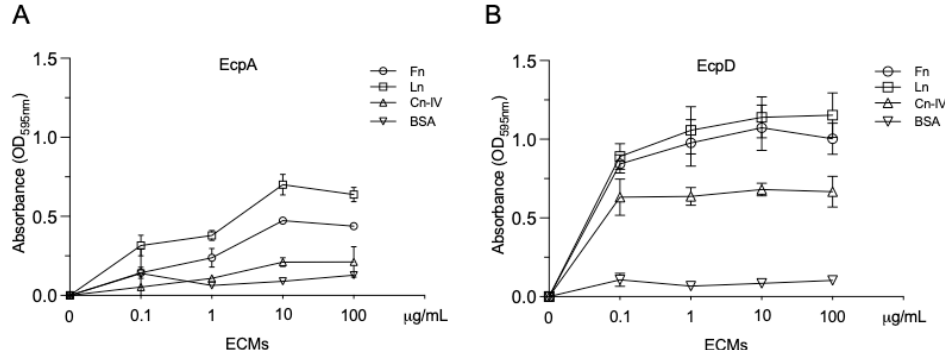
Figure 6. Dose-dependent binding of recombinant His-tagged EcpA and EcpD proteins to immobilized ECM glycoproteins. ( A , B ) Ten-fold dilutions of biotinylated Ecp proteins were added to immobilized ECM glycoproteins to determine dose-dependent binding. After washing, a streptavidin– peroxidase conjugate (1:500) was added to detect the bound biotinylated protein. BSA was used as a negative control. Data shown are the mean of three experiments performed in triplicate on different days (Mann–Whitney U test).